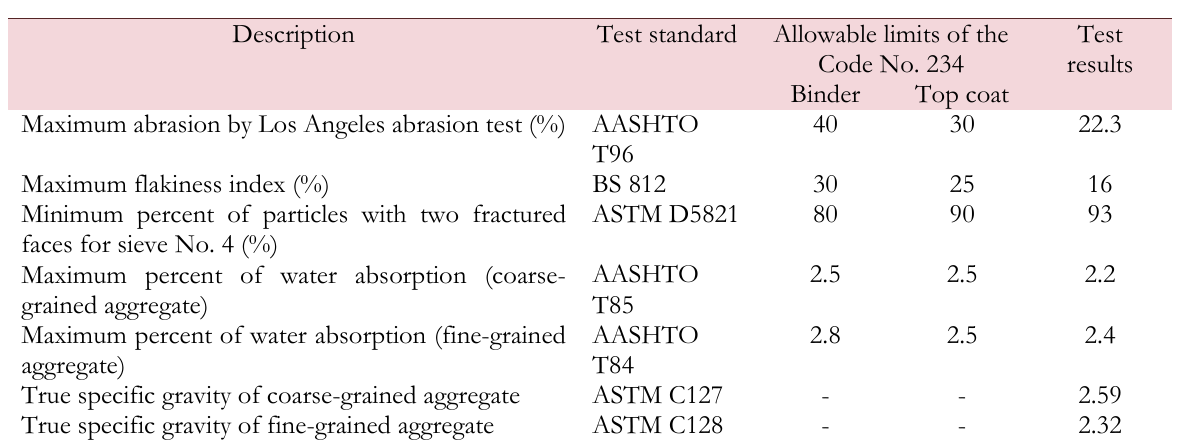
Table 2: Specifications of aggregate